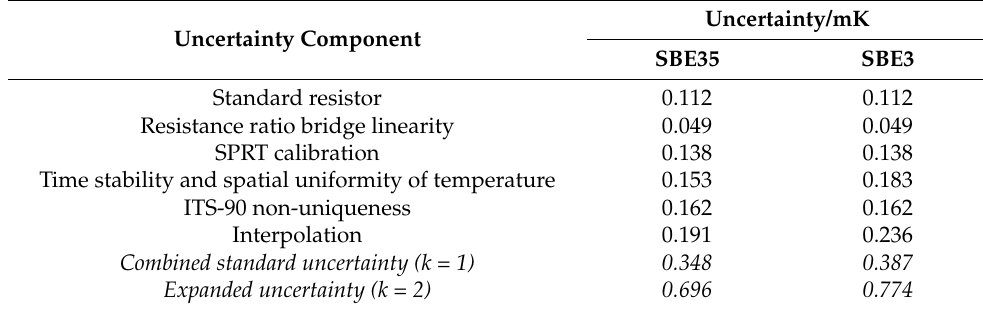
Table 2. Uncertainty budget for the recalibration of the SBE35 and the SBE3, by comparison to reference SPRTs in the sub-millikelvin calibration facility.